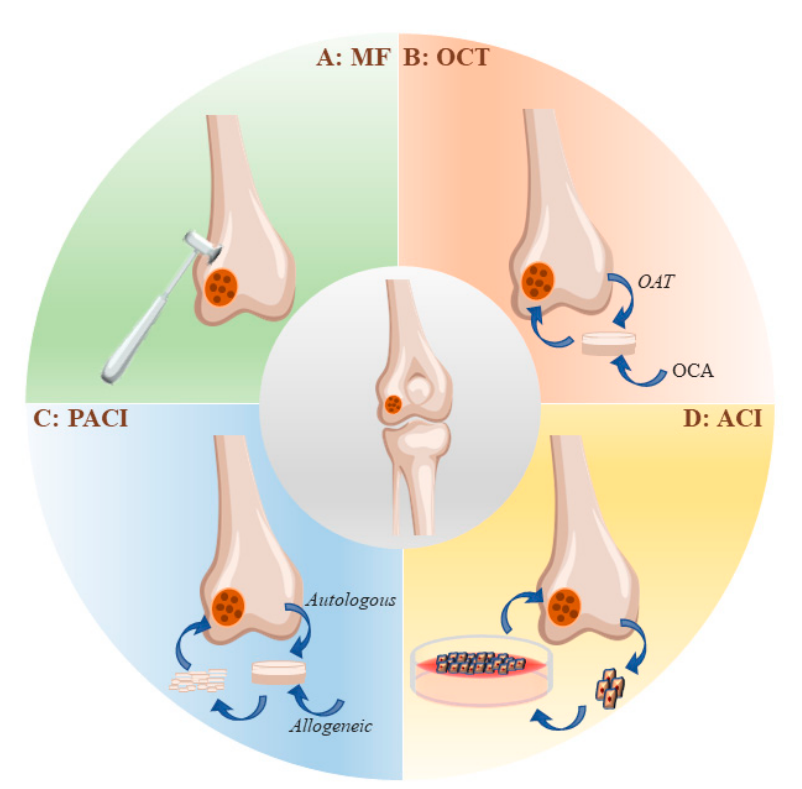
Figure 1. Strategies for the clinical management of articular cartilage injuries. ( A ) MF is a typical representative of bone marrow stimulation procedures. ( B ) OCT can be divided into two types according to the source of the graft. One type is known as osteochondral autologous transplantation (OAT) and the grafts are derived from the surface of the autologous non-weight-bearing joint. Another type is called osteochondral allograft transplantation (OCA) and the transplants come from the surface of the allograft joint. ( C ) Particulate articular cartilage implantation (PACI) means that articular cartilage is crushed into 1–2 mm sized particles and implanted into articular cartilage defects. PACI is divided into autologous PACI and allogeneic PACI, according to the source of grafts. ( D ) ACI refers to the collection of chondrocytes from the non-weight-bearing area of the autologous joint surface, their culture and amplification in vitro, and, finally, implantation into the cartilage defect.